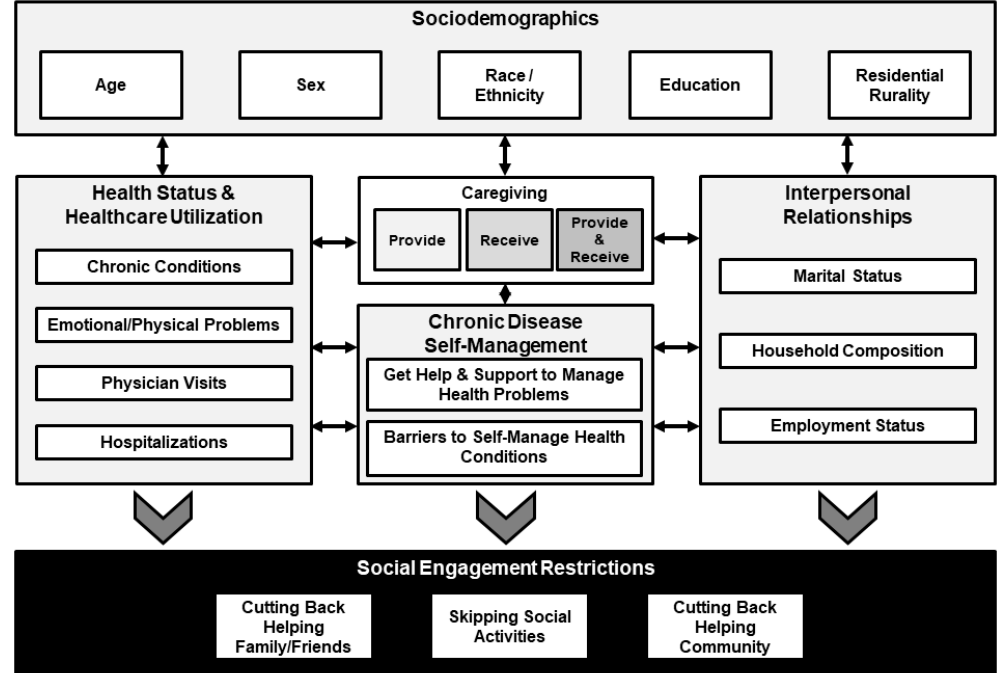
Figure 1. Conceptual framework.